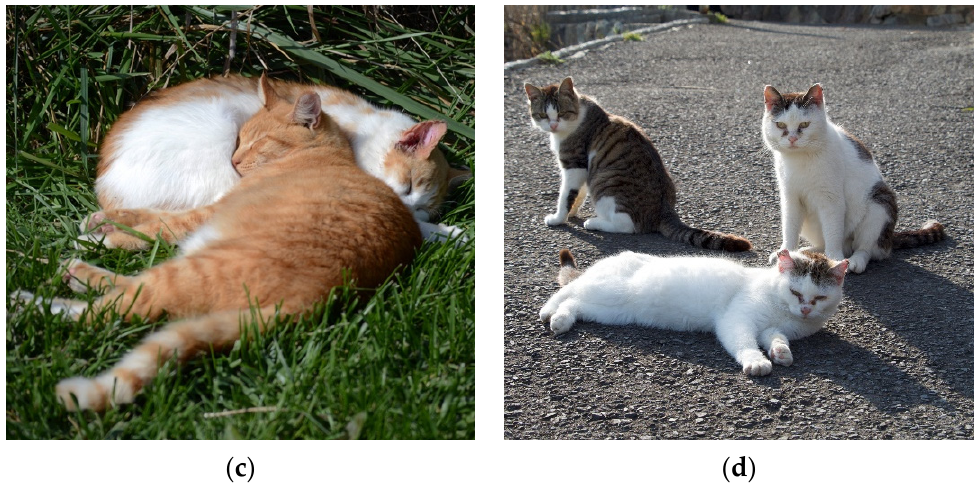
Figure 2. Photos of common FRC social behaviors taken by K. Vitale: ( a ) an orange male cat engages in an allorub with another adult male. Both cats display the tail up signal; ( b ) Two cats engage in a nose sniff, one cat displays tail up; ( c ) two male FRCs sleep together in bodily contact; ( d ) A group of cats sitting in proximity to one another on Tashirojima in Japan.